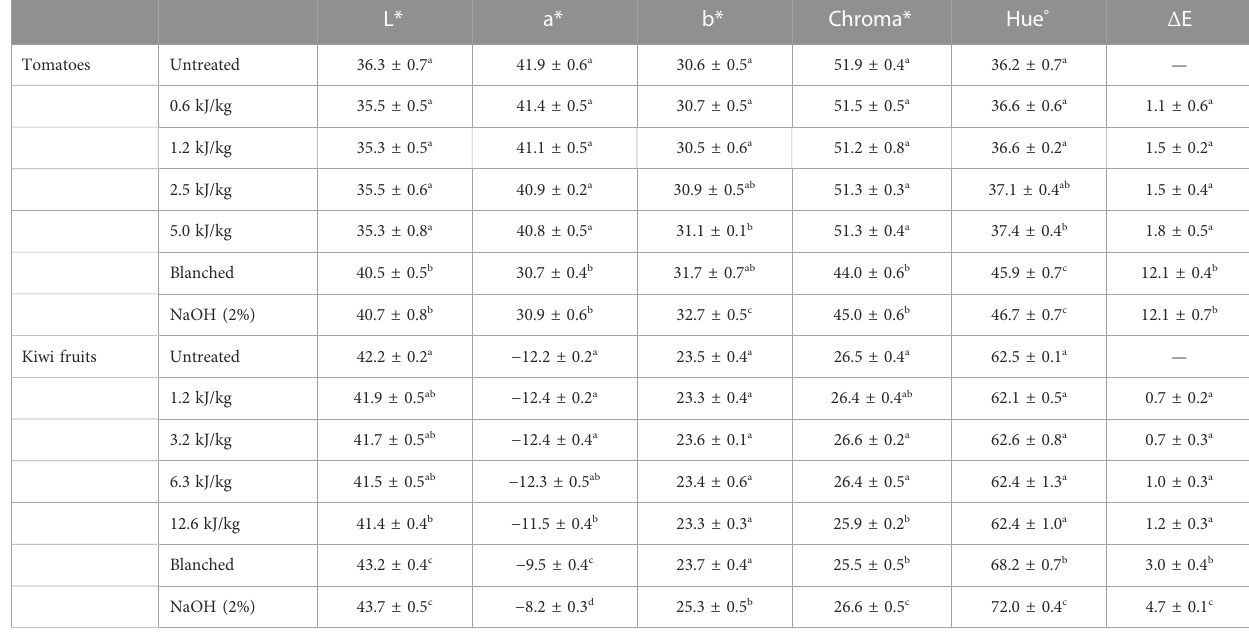
TABLE2L*,a*,b*,Chroma*,Hue ° andcolourdifference( Δ E)valuesforuntreated,PEFtreated(atdifferentenergyinputs,kJ/kg),blanchedandlyepeeledtomatoes and kiwi fruits. Different letters in the same column of each raw material indicate signi fi cant differences ( p <